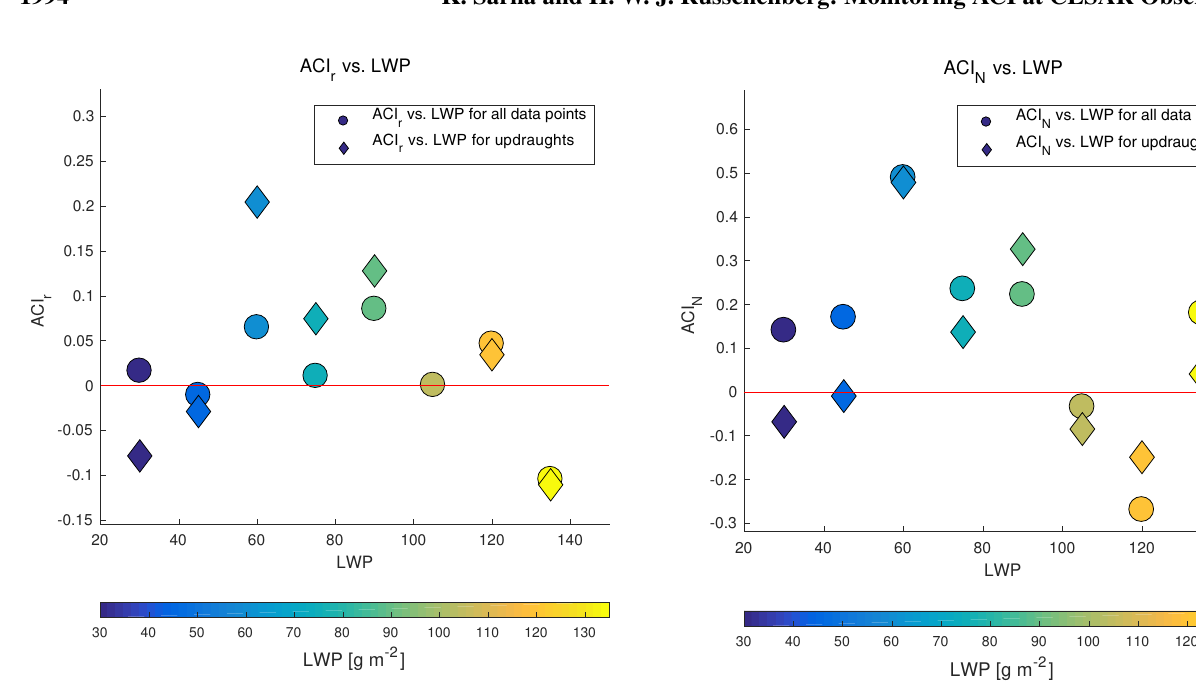
Figure 5. Scatter plot between ACI N and LWP for the data points located in the updraught areas of the aggregated data